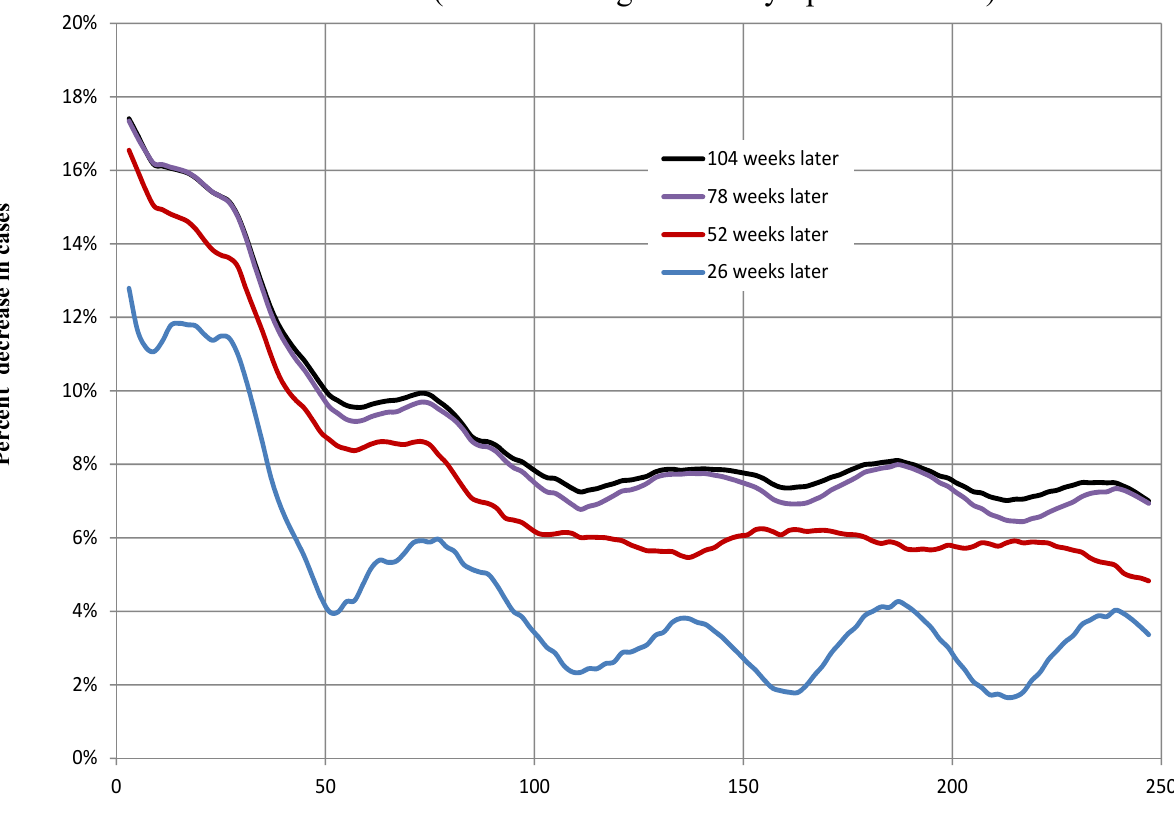
Figure 15. Ouest. The percent decrease in the total number of cases 26, 52, 78 and 104 weeks after the beginning of the second round of vaccination indicated on the abscissa. The onset of the immune response was assumed to begin a week later. We assume 70% efficacy of the vaccine. Percent reduction in cases after vaccination, the 2nd dose given in the indicated week (100% coverage of non-symptomatic